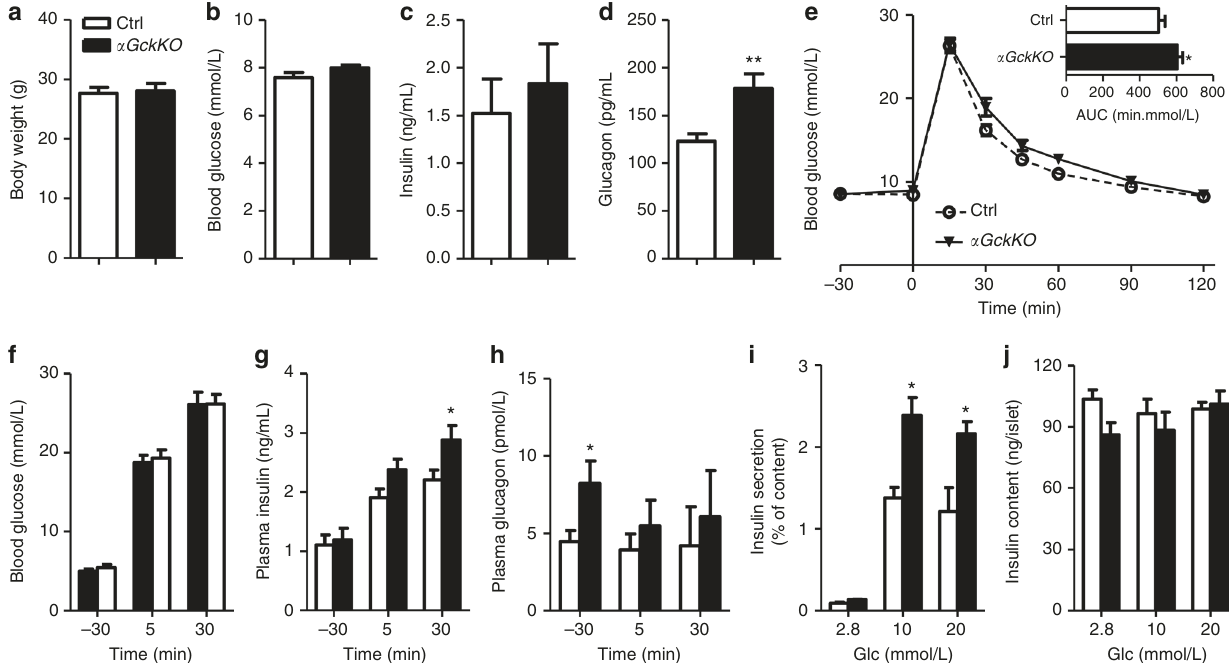
Fig. 4 Prediabetic phenotype in 36-week-old α GckKO mice. a Body weight, b Blood glucose, c Plasma insulin, and d Plasma glucagon in 36-week-old, fed female mice ( n = 9 Ctrl and n = 13 α GckKO mice ). ** p < 0.01 vs. Ctrl. e I.p. glucose tolerance test. Inset: area under the curve (AUC). * p < 0.05 vs. Ctrl. Student ’ s t -test. f Blood glucose, g Plasma insulin, and h Plasma glucagon, at the indicated time before or after i.p. glucose injection. * p < 0.05 vs. relative Ctrl. i Glucose-stimulated insulin secretion from islets isolated from 36-week-old mice. * p < 0.05 vs. relative Ctrl. Student ’ s t -test. j Total insulin content from 36-week-old mouse islets. Data showed in i , j represent the average of three independent experiments, each performed in duplicate. See also Supplementary Fig. 7. Data are represented as mean ±